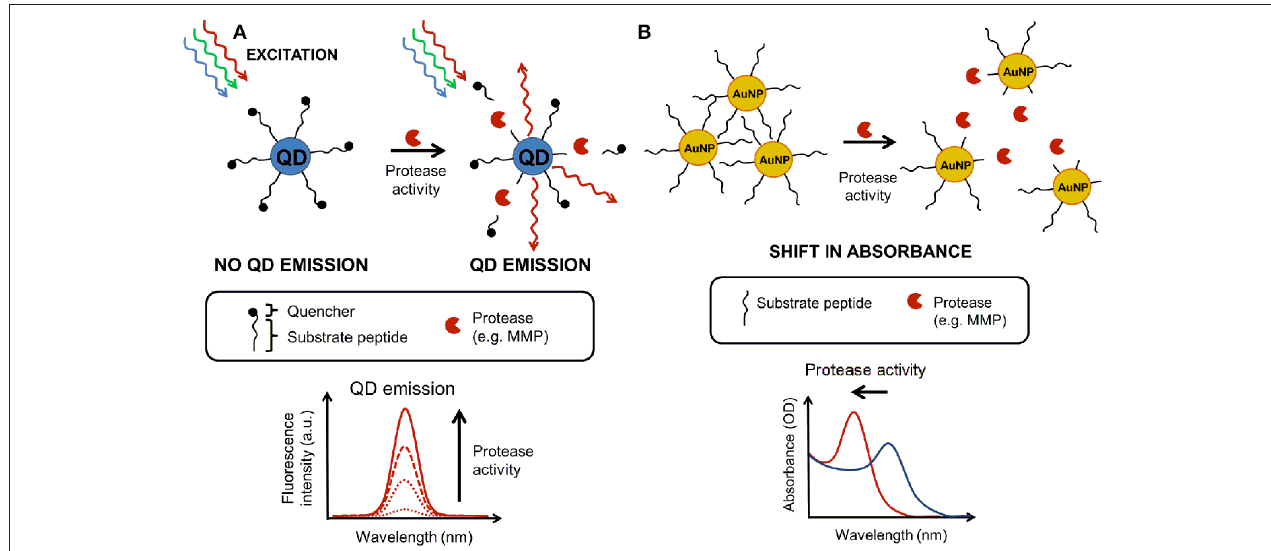
FIGURE 3 | Nanosensor measurements based on absorbance and fluorescence. (A) Principle of a fluorescence-based nanosensor where a quantum dot (QD) is linked to quencher molecules through substrate linkers. An active protease cleaves off the link leading to dequenching (enhanced fluorescence proportional to protease activity). (B) The principle of an absorbance-based nanosensor using gold nanoparticles (AuNP) functionalized with cross-linked peptides [causing the aggregation of the AuNP which have an absorbance peak around 600–700nm (OD)]. An active protease chews the substrate peptide, causing the disaggregation and a blue shift in the peak absorbance